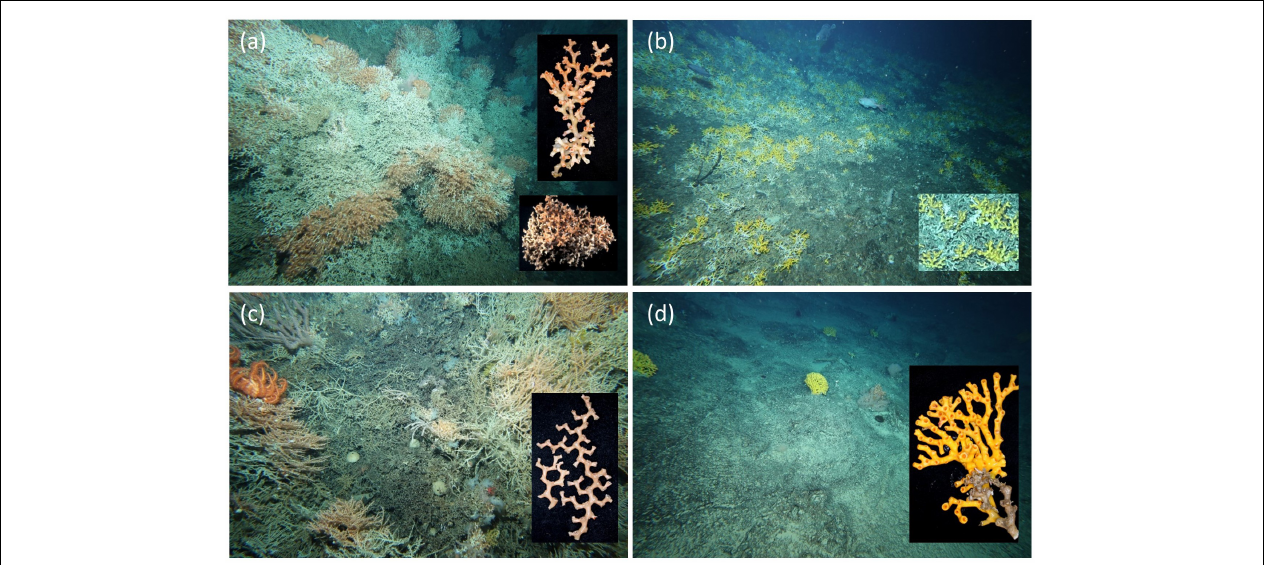
FIGURE 2 | Images of scleractinian corals in the study area illustrating the terms used to define indicators of impact; insets show the structure of the coral skeleton “matrix” and branching pattern: (a) Solenosmilia variabilis – “reef” formed of extensive matrix made sturdy and resilient by extensive branch anastomosis; upper inset shows large, intact and bushy branch, and lower inset a detached “clump” of anastomosed branches (seamount Z4, 977 m); (b) Dendrophyllia spp. (probably two species) – “reef” formed by extensive matrix of low, sparsely-branched colonies; inset shows “fragments” of coral branches (Sisters, 879 m); (c) Madrepora oculata – “patches” of matrix formed by dense, delicate, multiplanar bushes; inset shows large and small “fragments” with distinctive zig-zag branching (St Helens east, 1,179 m); (d) Enallopsammia rostrata – small “patches” of matrix formed by individual colonies; inset shows, uniplanar with corallites on one-side (Main Matt, 1,017 m).